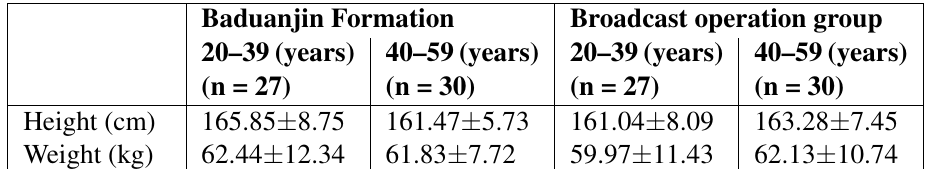
Table 1 Stepwise regression